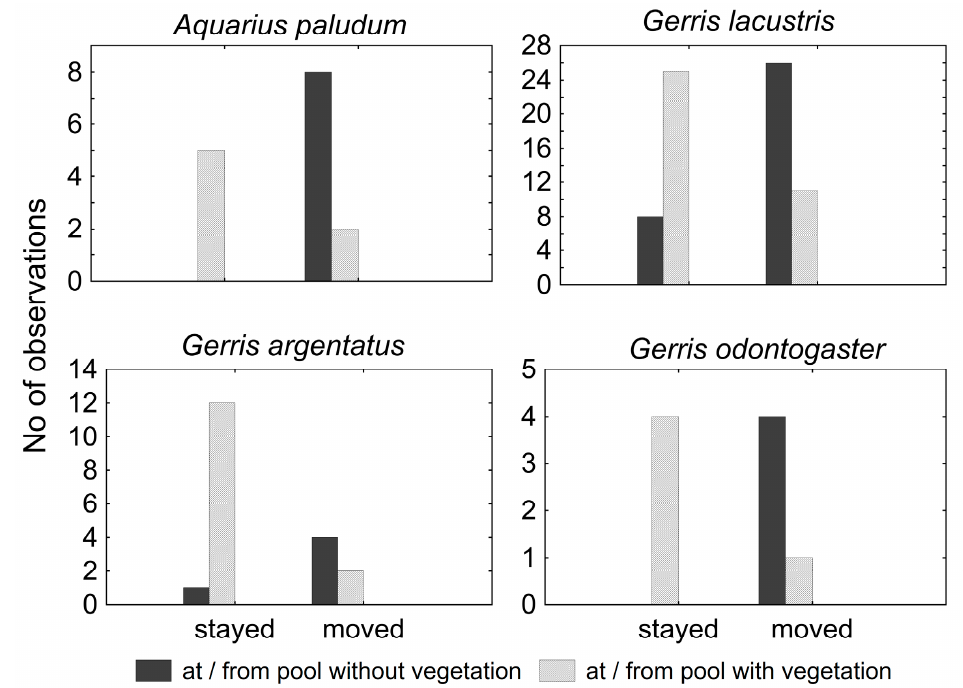
Figure 8. Water striders’ movements in small pools systems, concerning the vegetation (emergent and floating) of the pool. All species stayed in the vegetated pools but moved from the pools without vegetation.